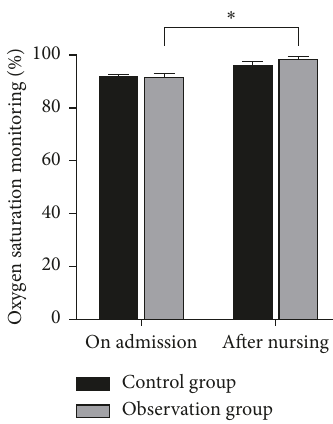
Figure 4: Comparison of the operation time between the two